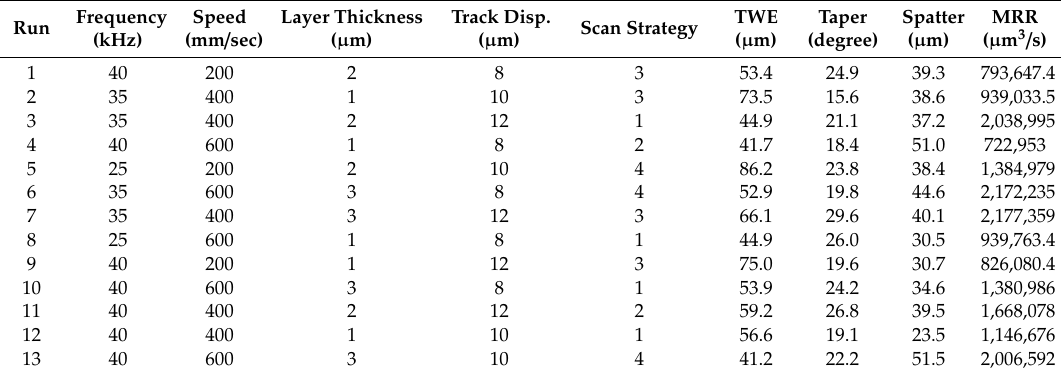
Figure 4. SEM images of the microchannel ( a ) Top view of the complete microchannel ( b ) cross-sectional image ( c ) measurement of TWE and taper ( d ) spatter measurement. Table 2. Design of experiment runs and experimental